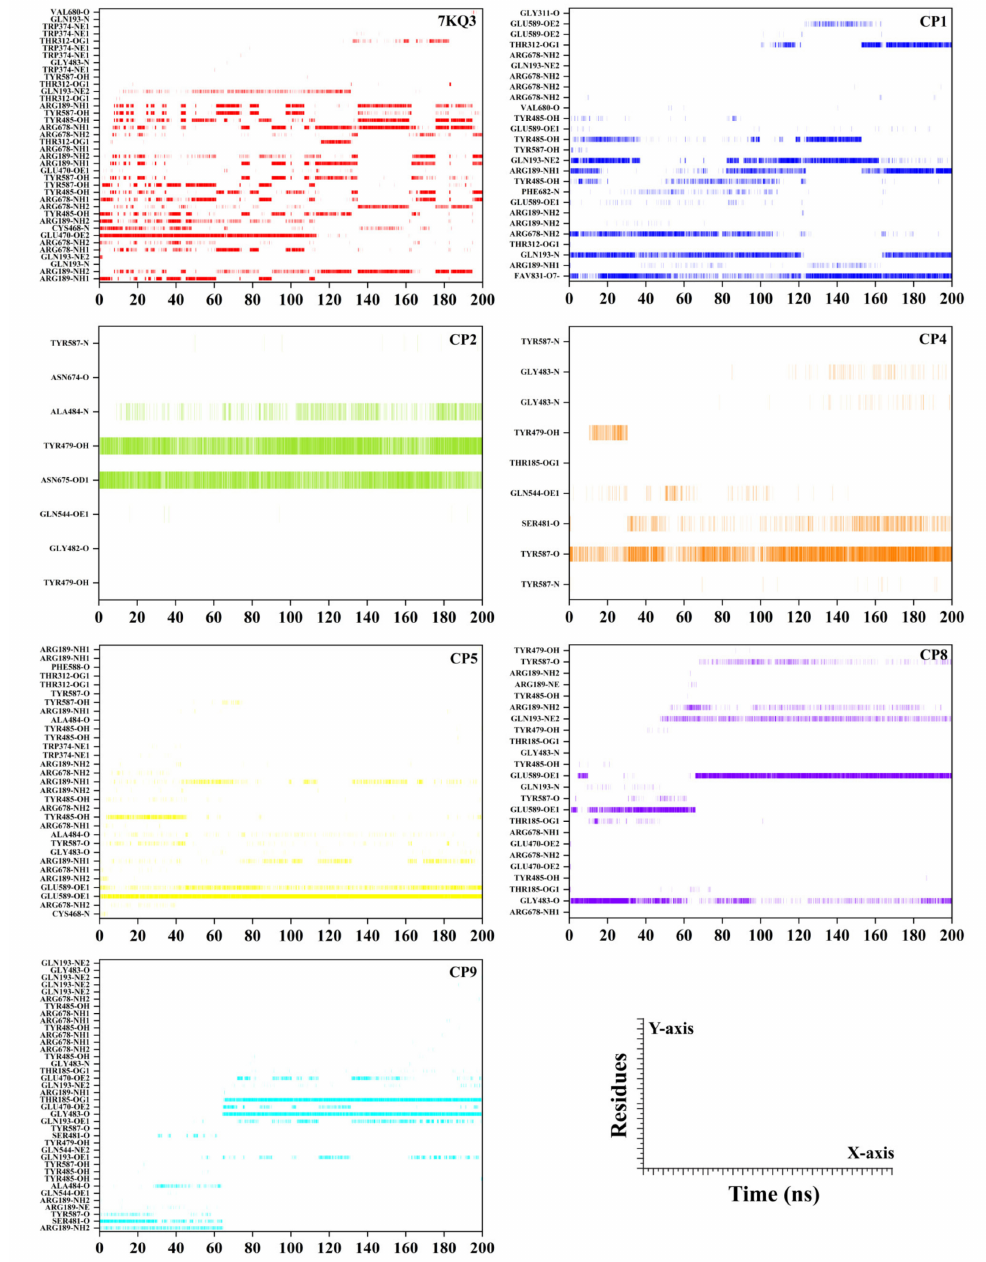
Figure 8. Hydrogen bond analysis of ligands with the active site residues of Isla during the